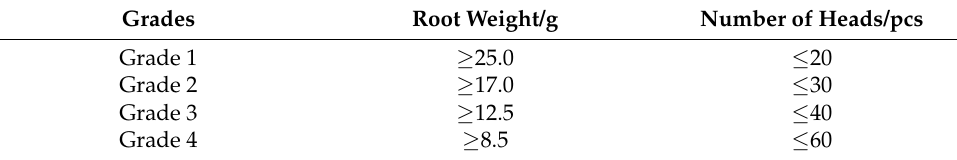
Table 1. Grading specification of taproot of Panax notoginseng . Grades Root Weight/g Number of Grades